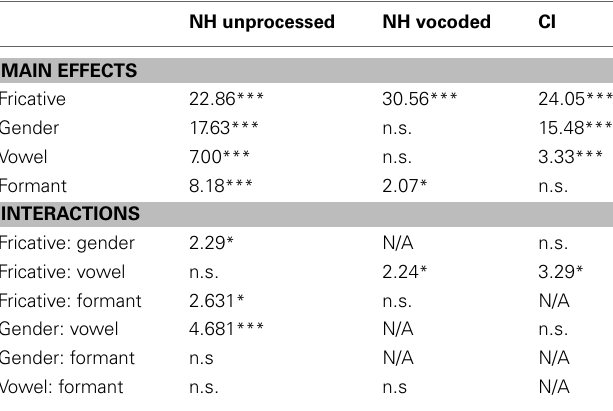
Table 4 | Main effects and interactions in experiment